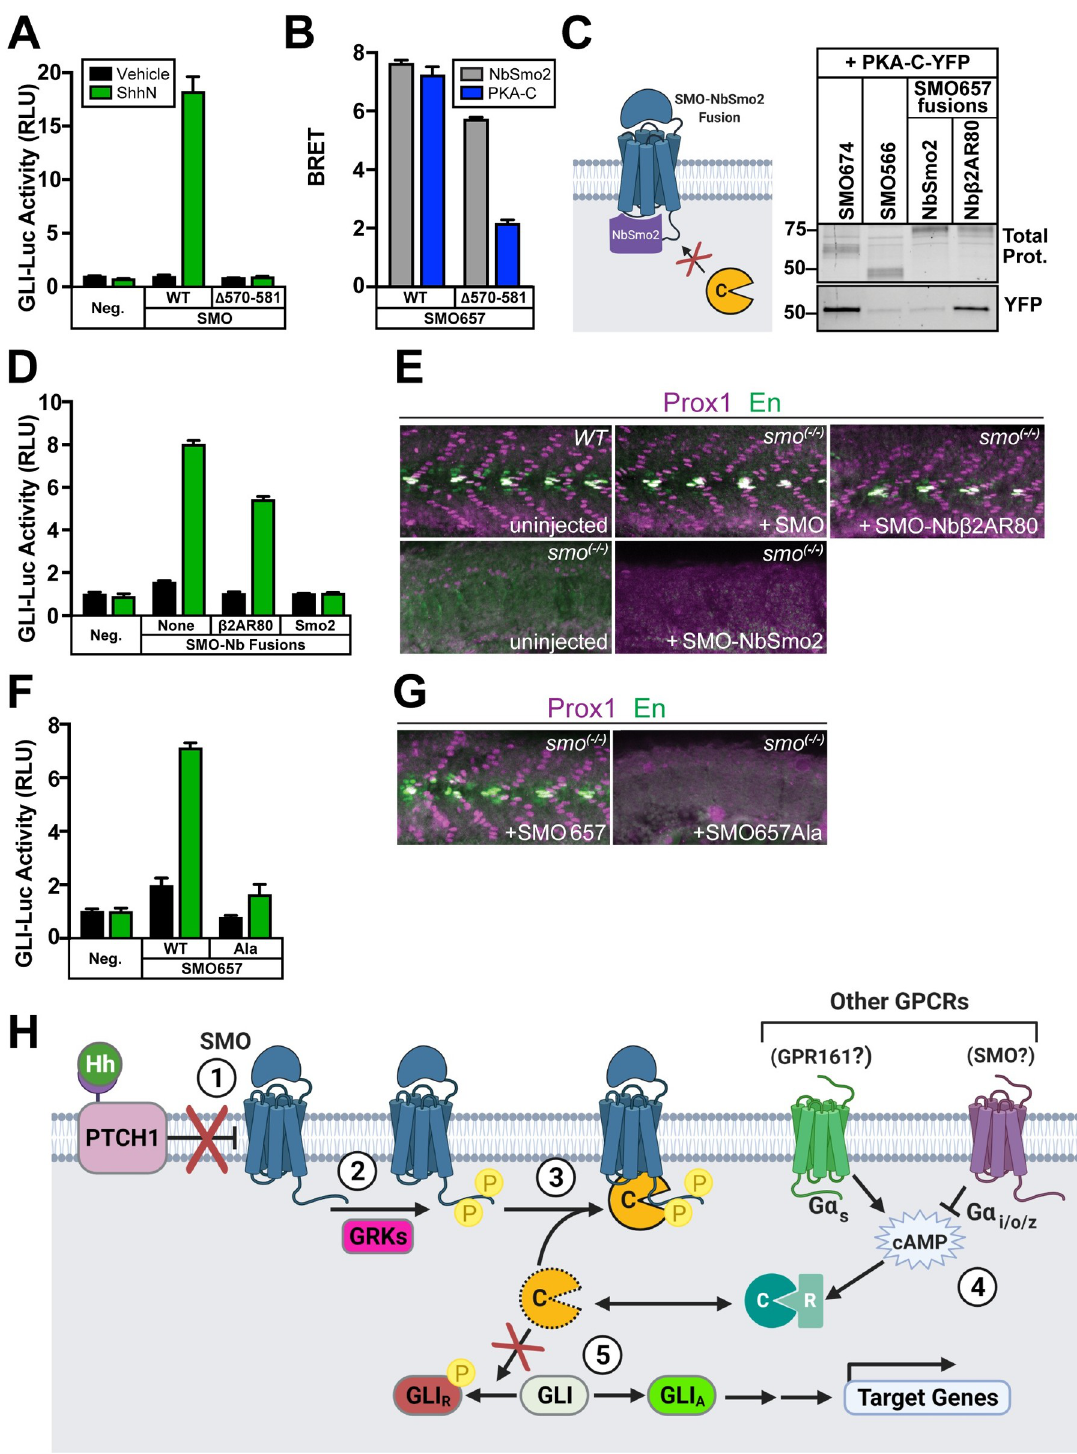
Fig 7. Hh signal transduction is blocked when SMO cannot bind PKA-C. ( A ) GLI transcriptional reporter assay in Smo − / − MEFs expressing wild-type SMO or SMO Δ 570–581, treated with conditioned medium containing the N-terminal signaling domain of Sonic hedgehog (ShhN, green) or control, non-ShhN-containing conditioned medium (Vehicle, black). GFP serves as a negative control (“Neg.”). ( B ) BRET in HEK293 cells between nanoluc-tagged wild-type or Δ 570–581 forms of SMO657 as donor, with YFP-tagged NbSmo2 (gray) or PKA-C (blue) as acceptor. ( C ) Left: Schematic of SMO-NbSmo2 fusion, predicted to block interactions with SMO